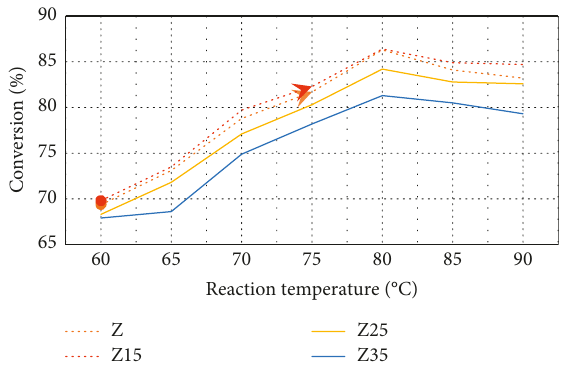
Figure 2: Monomer conversion Table 1: Changes in viscosity of emulsions.